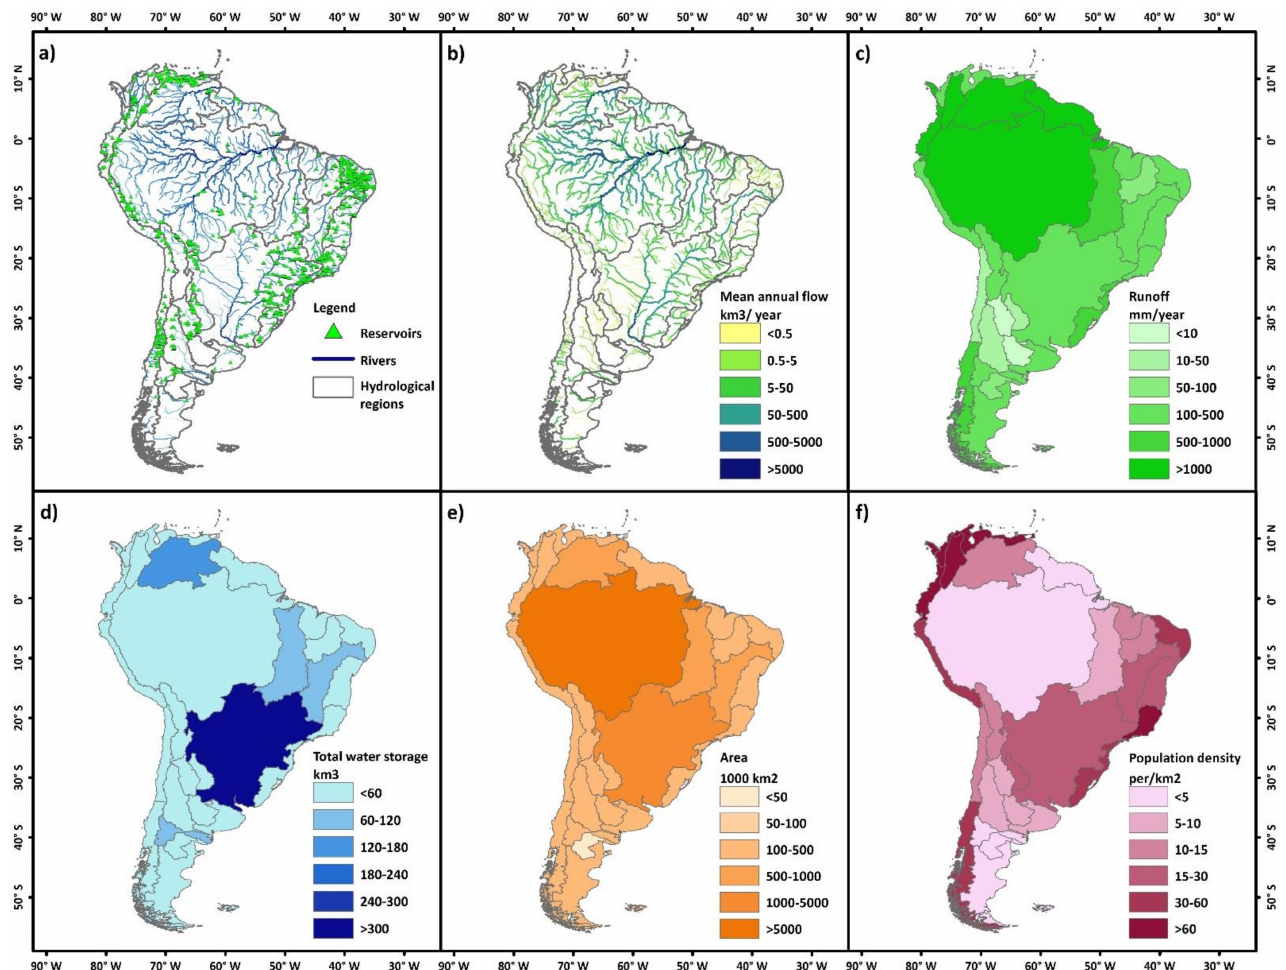
Figure 2. Inputs and main characteristics considered for this study mapped by hydrological region: ( a ) Inputs: the blue lines represent the rivers derived from the HydroSHEDS dataset [63], the grey lines represent the major hydrological regions of South America determined by FAO [56], and the green triangles represent the reservoirs from the DDSA database [23] pare, ( b ) mean annual flow (km 3 /yr.), ( c ) runoff (mm/yr.), ( d ) total water storage (km 3 ), ( e ) area of the hydrological region ( × 1000 km 2 ), and ( f ) population density (per/km 2